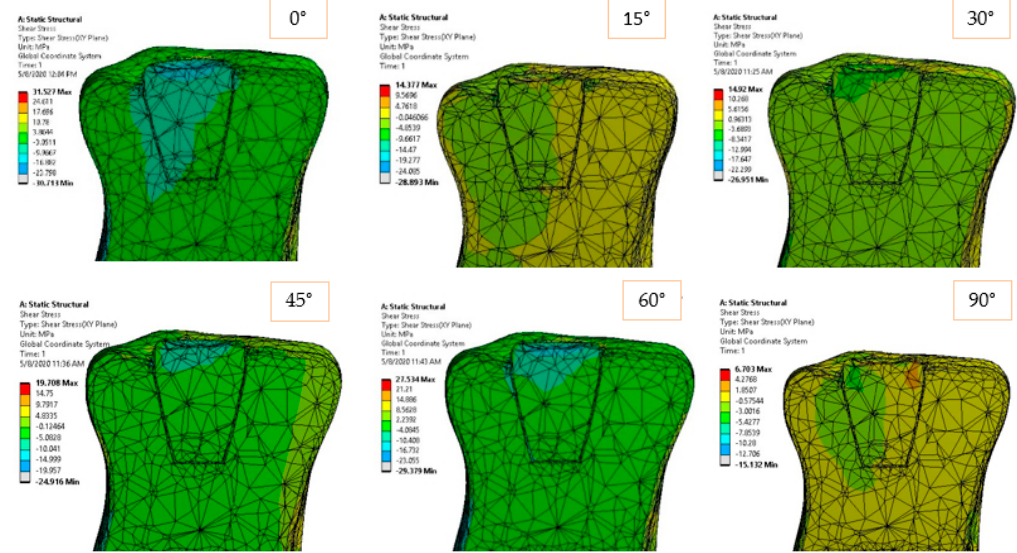
Figure 6. Equivalent elastic stress for 170 N load and 0°–90° loading direction.